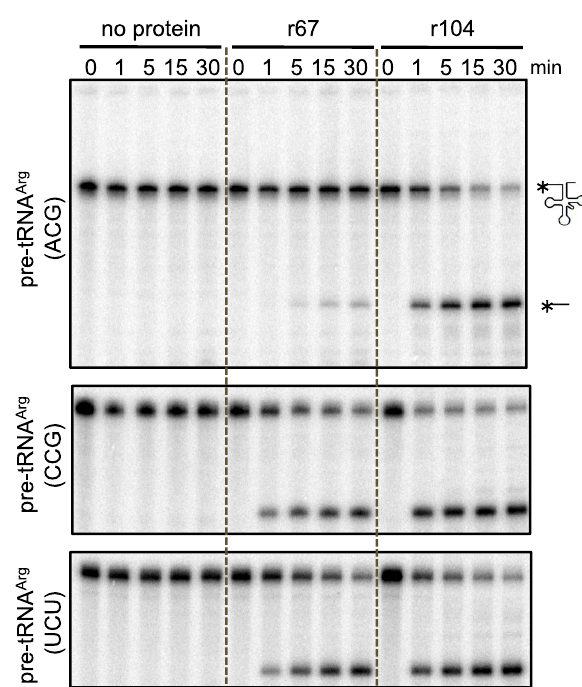
Figure 6. Pre-tRNA cleavage assay of the recombinant proteins r67 and r104. Reactions containing 500 nM of chloroplast 5 9 - 32 P-pre- tRNA Arg (ACG) (upper), tRNA Arg (CCG) (middle), or tRNA Arg (UCU) (lower) and 500 nM of recombinant protein were quenched at 1, 5, 15, and 30 min points, resolved on 8% denaturing PAGE, and analyzed with a